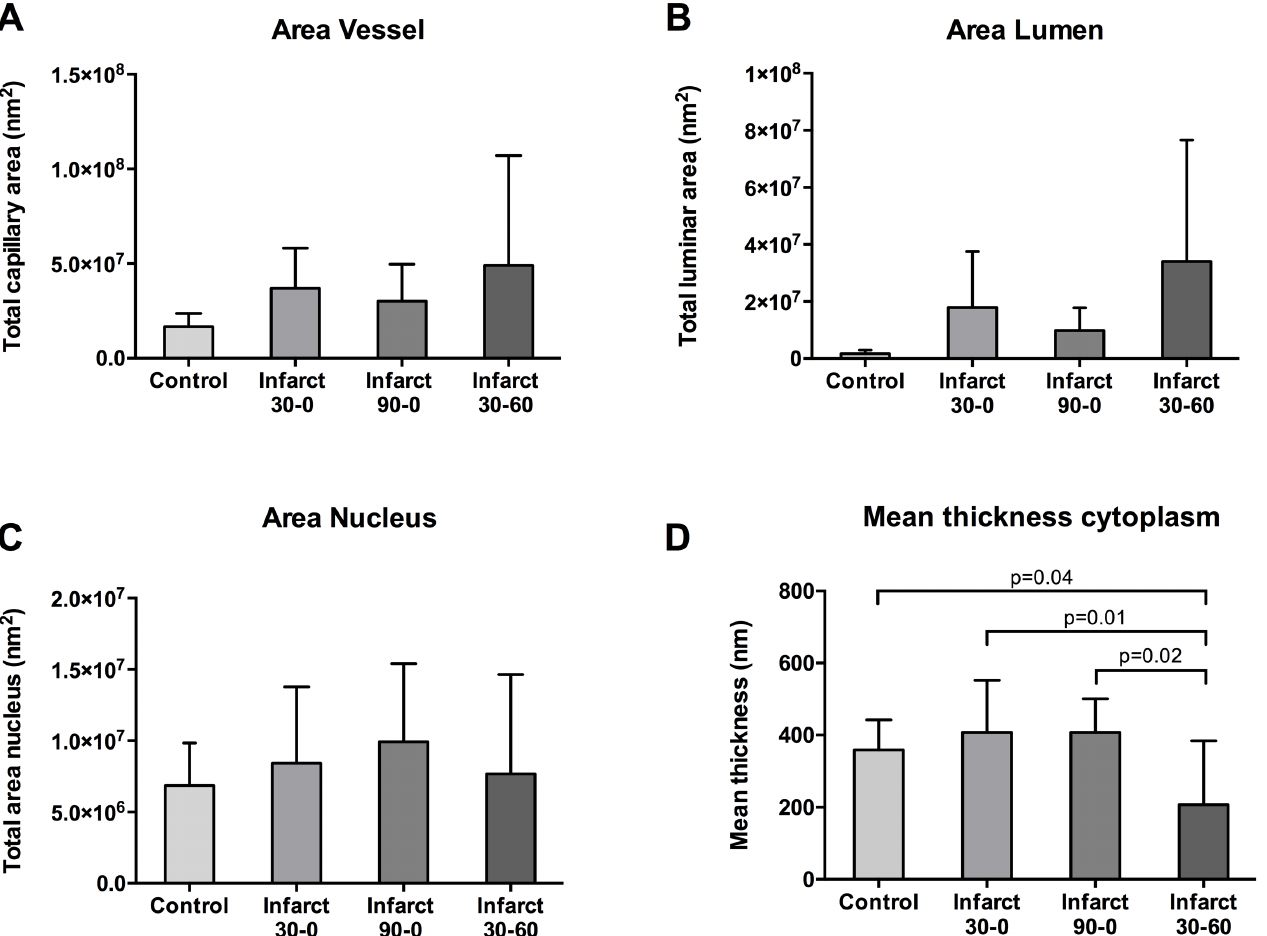
Fig 5. Area measurements of microcirculation. A Total vessel area in nm 2 (including cytoplasm, lumen and nucleus). B Area of vessel lumen in nm 2 . C Area of endothelial nuclei in nm 2 . D Mean thickness of the capillary cytoplasm in